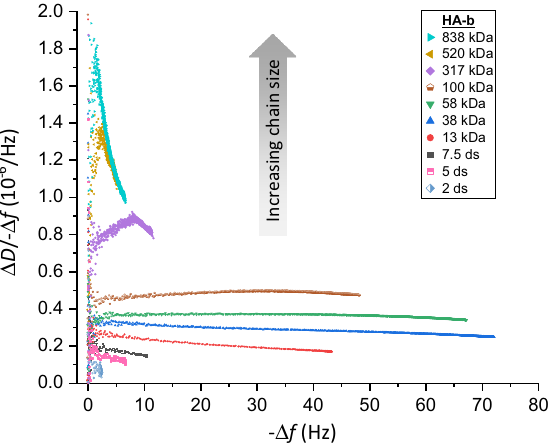
Figure 3. Δ D /− Δ f analysis robustly discriminates HA sizes. Parametric plots of Δ D /− Δ f versus − Δ f ( i = 3; frequency shifts are normalised by i ) during the formation of brushes of HA with defined sizes (as indicated with symbol and colour code; see Fig. S2 for original data.